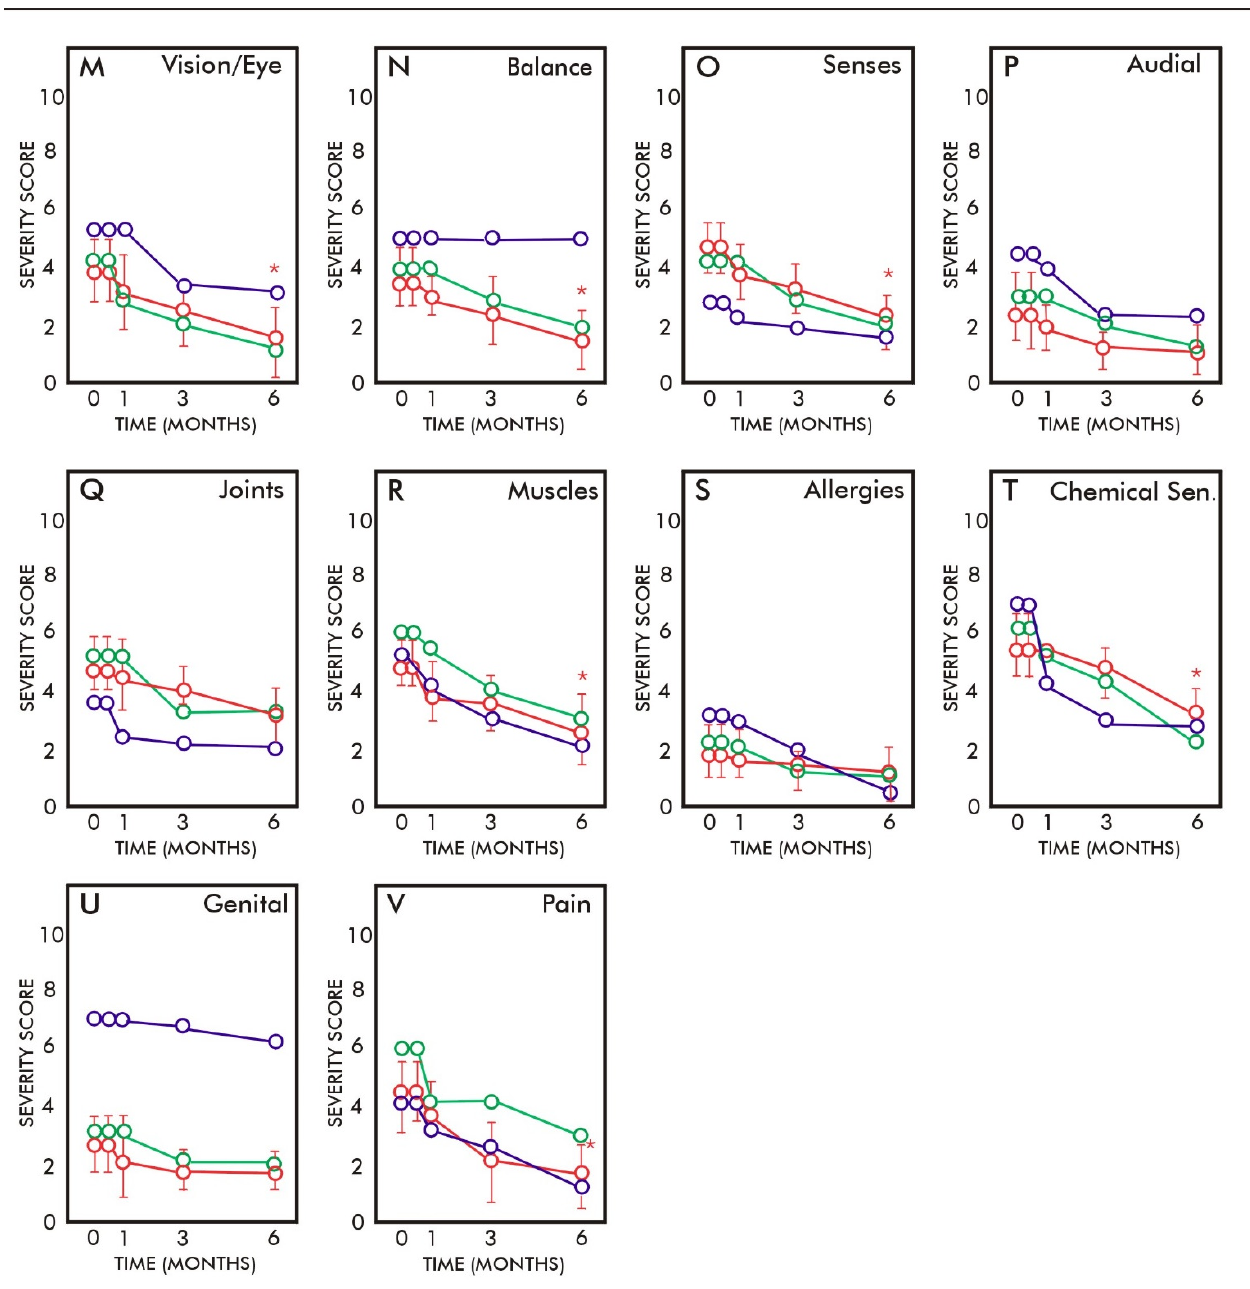
Figure 3. Symptom category scores with time reported by Study Participants who took the oral MLR supplement NTFactor Lipids ® (6 g per day). The mean symptom category severity scores ( ± standard deviations) of all trial participants (red symbols) are compared to two individual participants (green and blue symbols) before the trial, and at one week, one month, 3 months and 6 months. ( A ) Heart symptoms, ( B ) nasopharyngeal symptoms, ( C ) breathing difficulties, ( D ) neurologic symptoms, ( E ) sleep disturbances, (F ) fatigue, ( G ) infection(s), ( H ) hair/scalp disturbances, ( I ) skin disturbances, ( J ) gastrointestinal symptoms, ( K ) urinary symptoms, ( L ) oral cavity disturbances, ( M ) vision/eye disturbances, ( N ) balance disturbances, ( O ) sense disturbances, ( P ) audial disturbances, ( Q ) joint symptoms, ( R ) muscle symptoms, ( S ) allergies, ( T ) chemical sensitivities, ( U ) genital disturbances and ( V ) pain. (*, p < 0.01; **, p < 0.001).